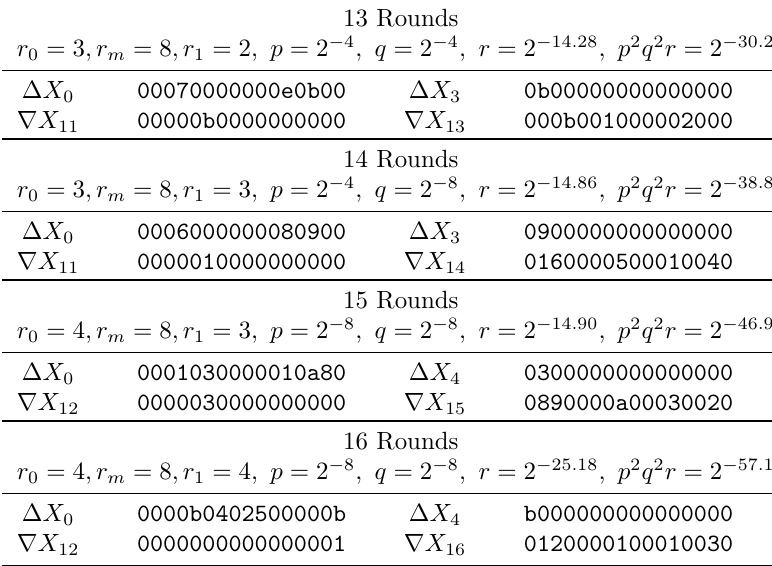
Table 14: Specification of Sandwich Distinguishers for LBlock . 13